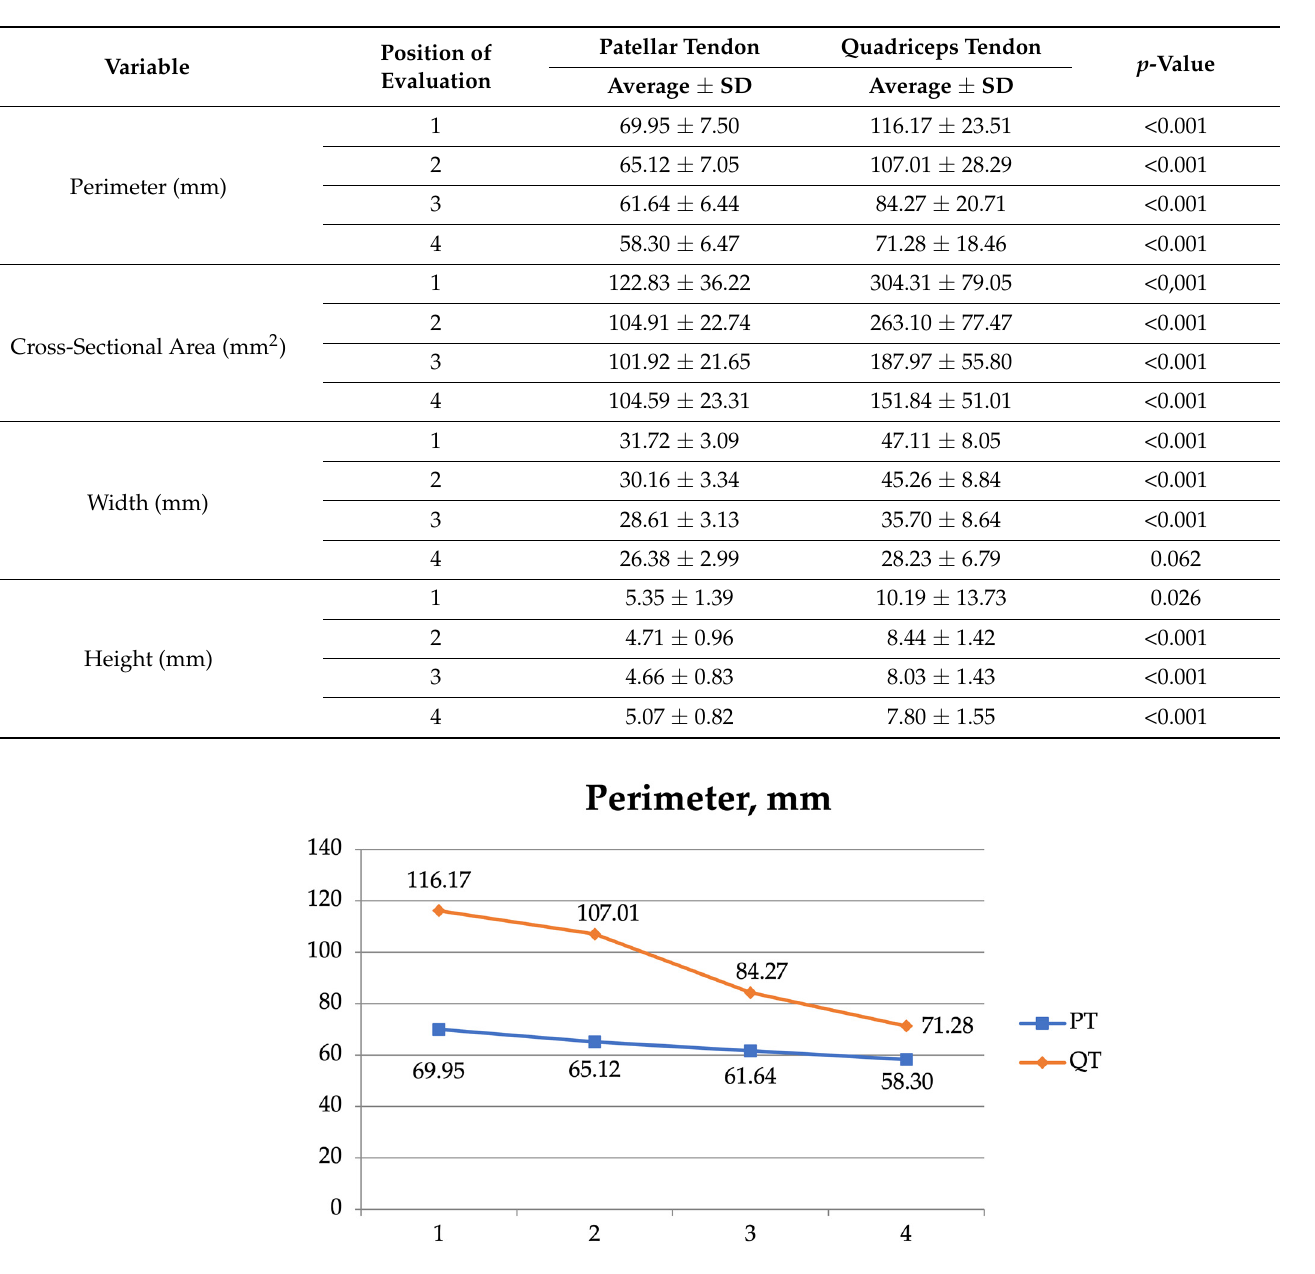
Figure 5. The cross ‐ sectional area (CSA) of the patellar tendon (PT) and the quadriceps tendon (QT) at the 4 measurement sites.